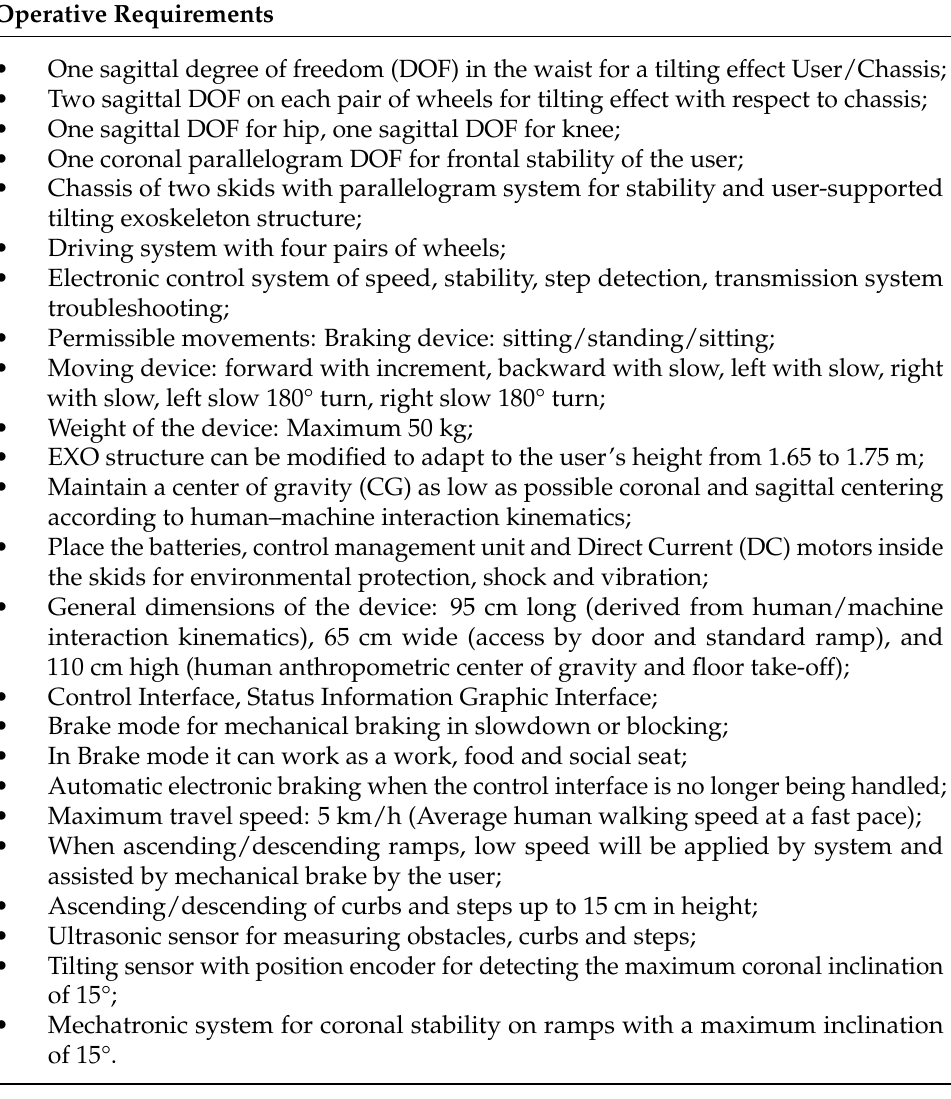
Table 3. Operative